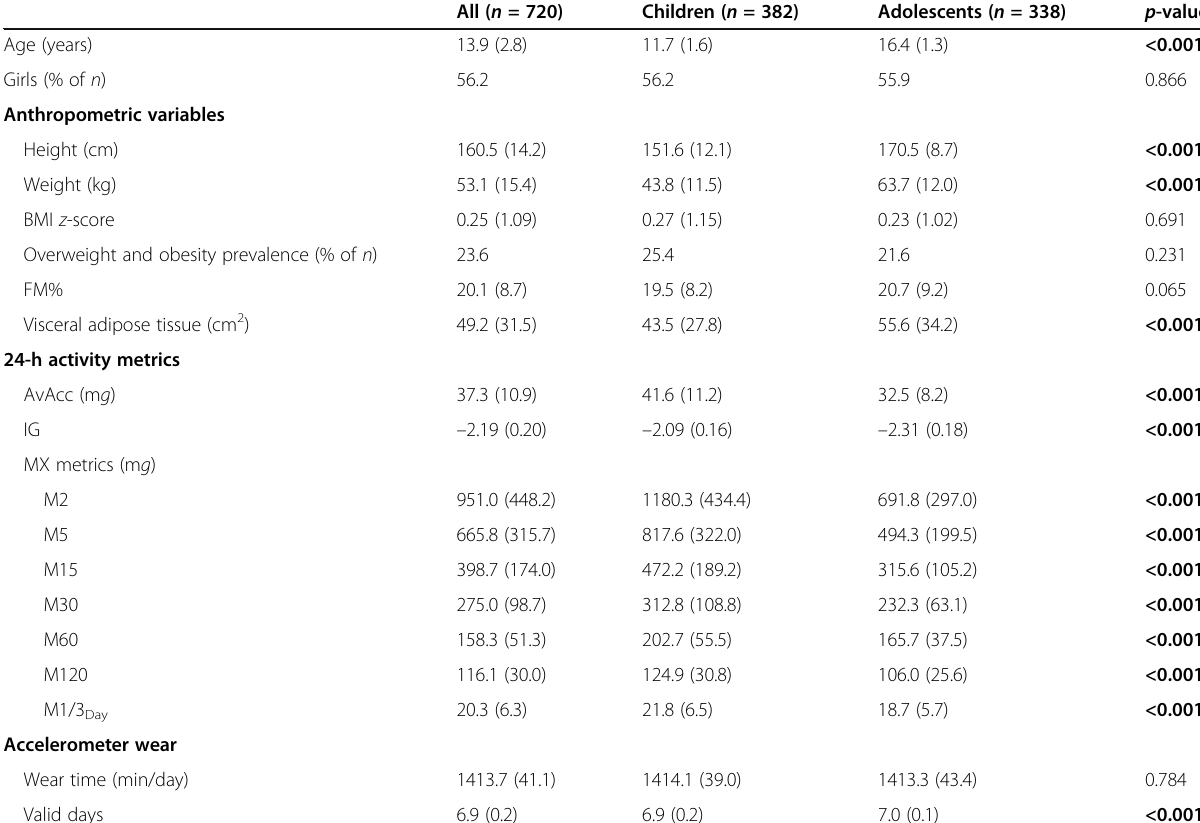
Table 1 Characteristics of all the participants, children, and adolescents and the differences between them All ( n = 720)